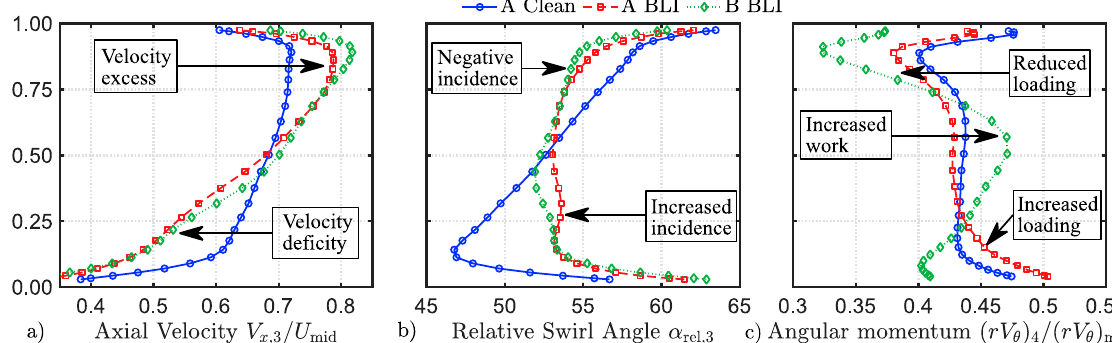
Figure 19. Measured spanwise distributions at the ADP of: ( a ) axial velocity, ( b ) relative swirl angle, ( c ) angular momentum.